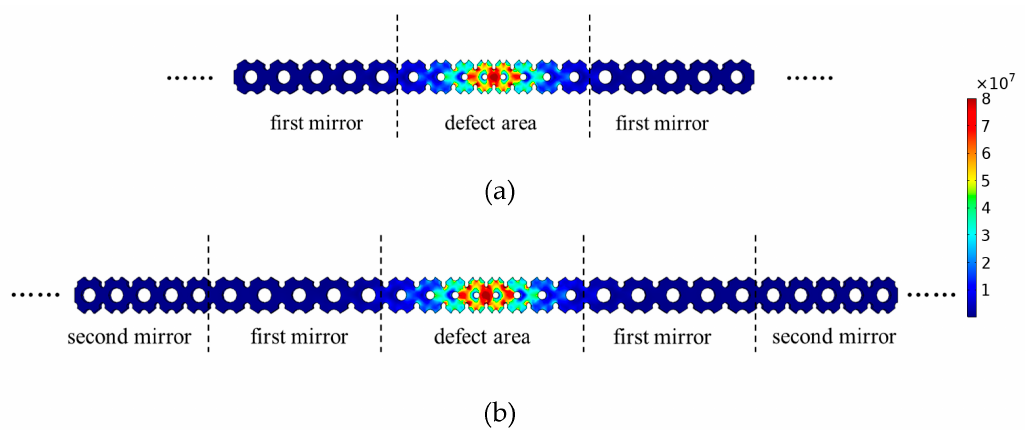
Figure 3. ( a , b ) Optical mode diagrams of the single-mirror and the hetero-optomechanical crystal nanobeam resonators, respectively.